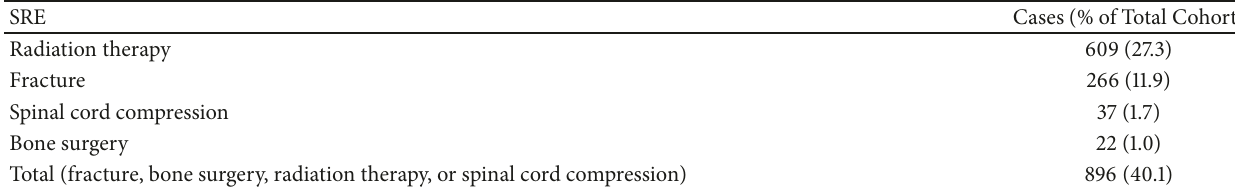
Table 3: Number of first cases of